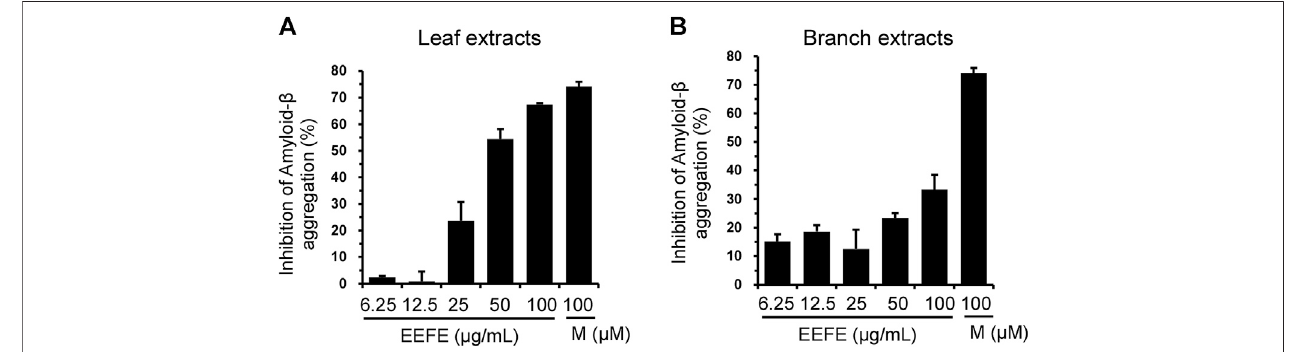
FIGURE2| EffectsofEEFEleavesandbranchesonamyloid- β (A β )aggregation. (A,B) A β aggregationassaywasperformedbyreactionwith6.25,12.5,25,50,or 100 μ g/ml concentrations of EEFE leaves (A) and branches (B) with A β peptides, followed by the addition of Thio fl avin T. Thio fl avin T fl uorescence was assessed at an